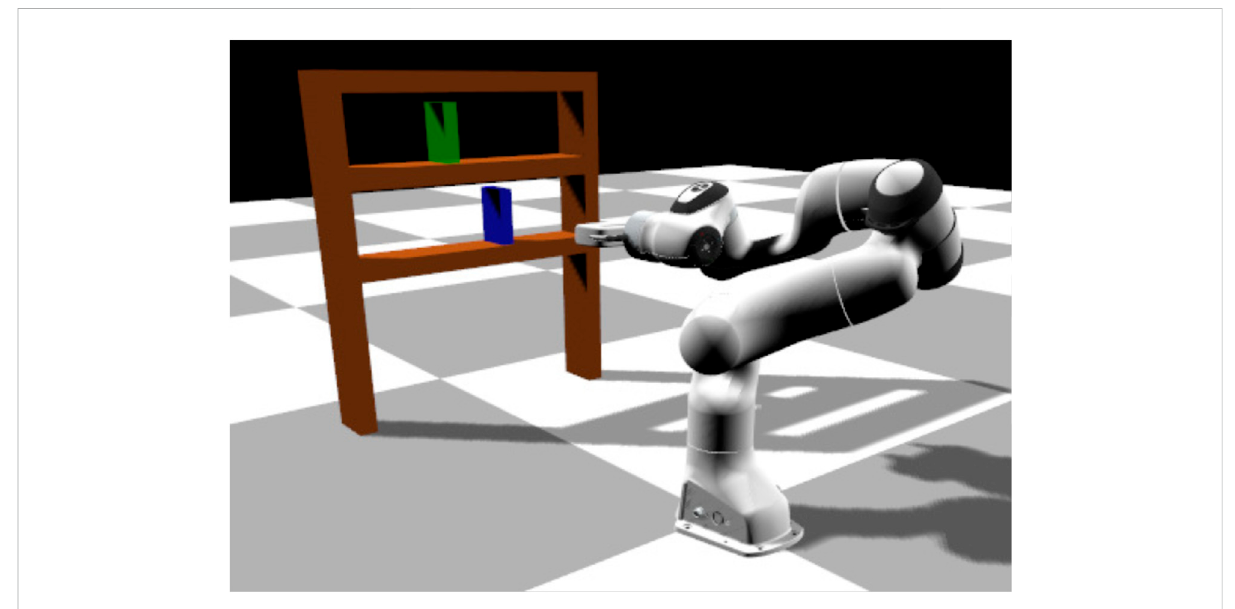
FIGURE 4 Bookcase task: the robot needs to grasp a book (in blue) and place it in a goal position (in green).